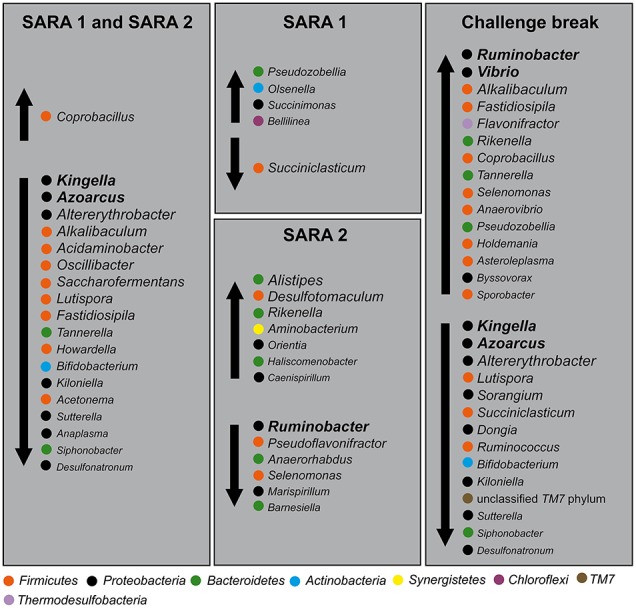
Putative indicator phylotypes for non-SARA and SARA conditions. Genera with significant shifts within SARA 1, SARA 2, and challenge break were grouped regarding their change in abundance under SARA conditions. Vertical arrows indicate an increase or decrease with SARA challenge or challenge break. Phyla are indicated with colored dots. Abundance ranking of taxa is indicated by font size (the larger, the more abundant).